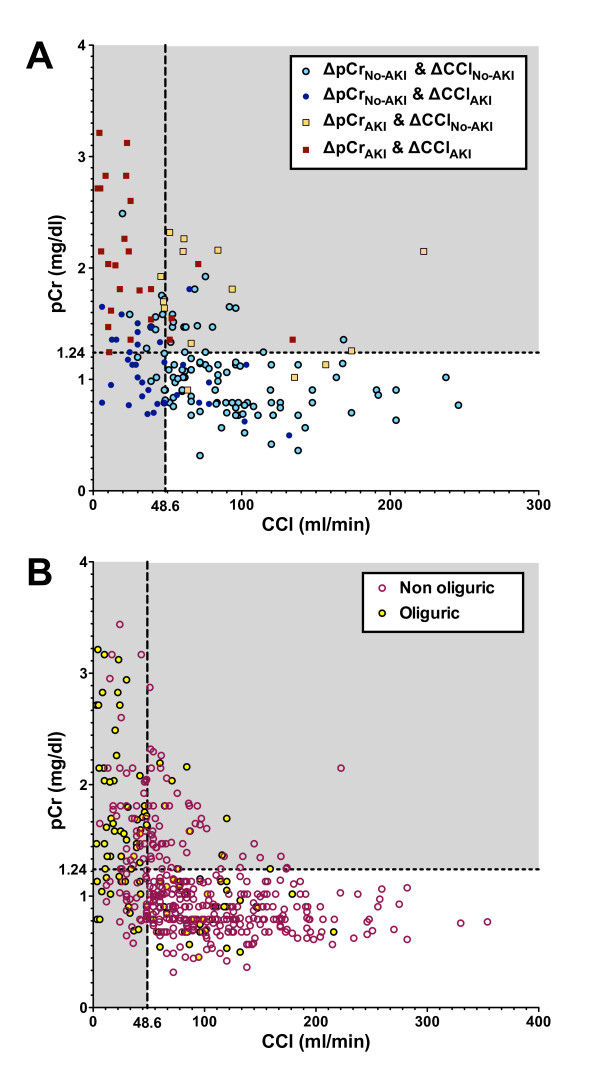
Comparison of creatinine clearance (CCl) with plasma creatinine (pCr) on entry into the ICU in the (A) known baseline cohort and (B) entire cohort. Dashed lines represent optimum cut-points for diagnosis of acute kidney injury (AKI) according to a change in CCl (CCl < 48.6 ml/min) or change in pCr (pCr > 1.24 mg/dl). (A) The four possible diagnoses (i) No AKI (ΔpCrNo-AKI and ΔCClNo-AKI), (ii) AKI by the clearance criterion only (ΔpCrNo-AKI and ΔCClAKI), (iii) AKI by the pCr criterion only (ΔpCrAKI and ΔCClNo-AKI) or (iv) AKI by both criteria (ΔpCrAKI and ΔCClAKI) are illustrated by squares for ΔpCrAKI and closed circles or squares for ΔCClAKI. (B) Oliguric (urine output < 0.5 ml/kg/h average over 4 h, closed circles), and non-oliguric (open circles) for the entire cohort. No-AKI (CClNo-AKI): without AKI; ΔpCr: relative change in pCr from baseline; ΔCCl: relative change in CCl from Cockcroft-Gault (CG) baseline; AKI (pCrAKI): with AKI.